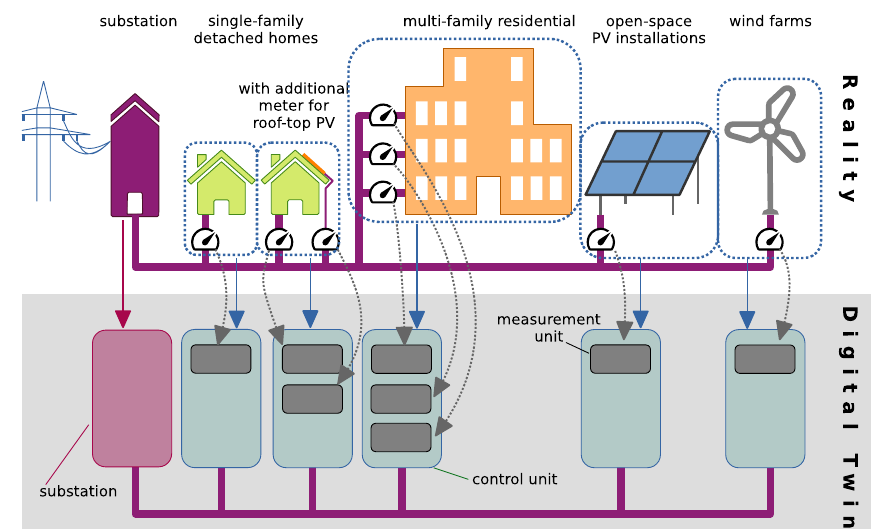
Fig. 1 The correspondence of the real energy system and the abstraction in the digital twin. The real modeled system is shown above. Below, the correspondence to the concepts of our digital twin are depicted: Turquoise boxes represent control units, and gray boxes represent measurement units. Additionally, the possible representation of local wind farms and open-space photovoltaic installations is illustrated on the right. Grey arrows represent the transformation of smart meters to measurement units, blue arrows represent the transformation of real entities to control units, crimson arrows depict the transformation of